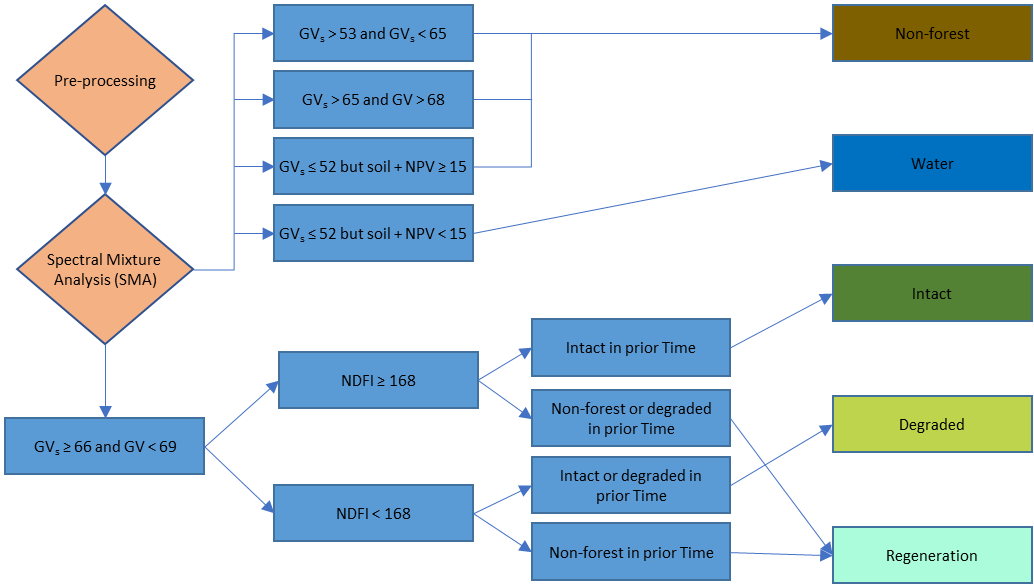
Figure 4. Decision Tree and Definition of Forest for Terai Arc